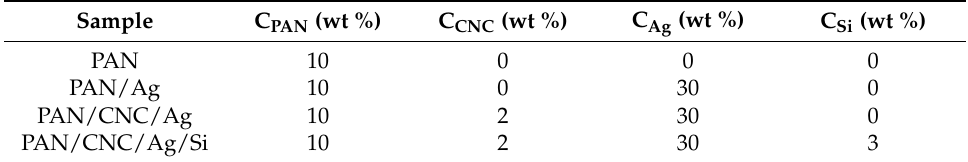
Table 1. Compositions of different electrospinning suspensions